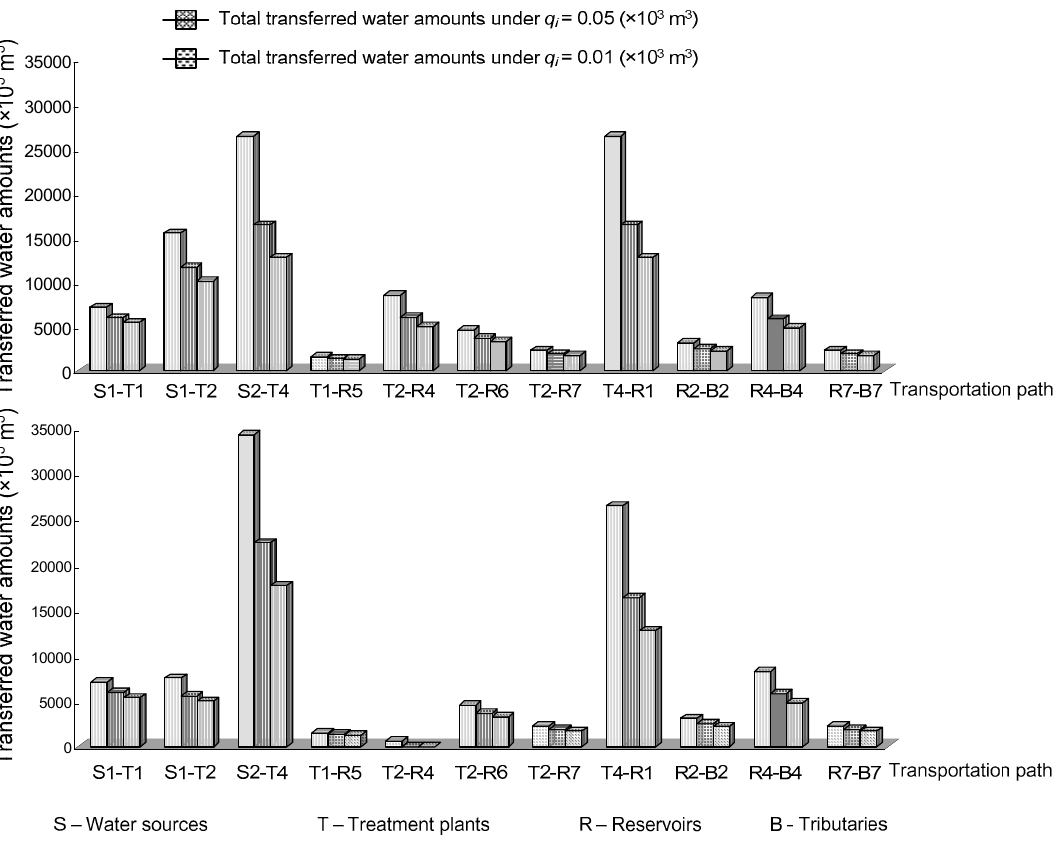
Figure 4. Total transferred water amounts under various q i values.